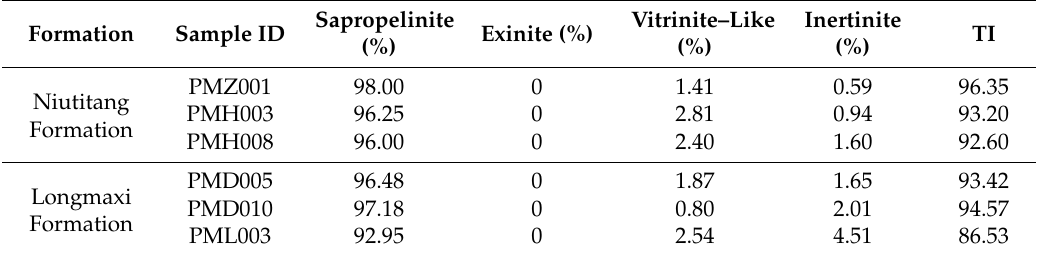
Table 2. The microscopic constituents of organic matter of the shale